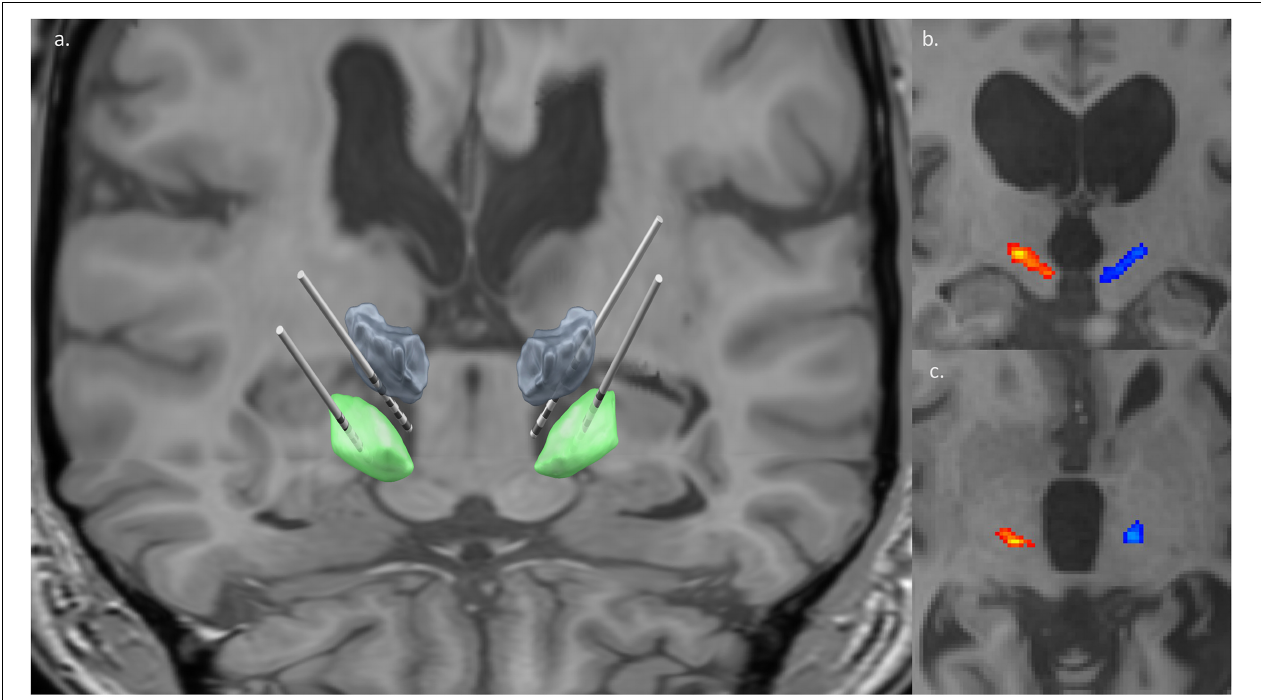
FIGURE 2 | Lead and white matter tract reconstruction. (a) Four DBS [bilateral Vim/DRTT (gray), bilateral GPi (green)] leads reconstructed with patient’s preoperative T1 non-contrast MRI as backdrop and DISTAL atlas segmentations of deep brain nuclei. Two distal contacts of Vim leads can be seen intentionally deep to the nucleus, targeting white matter fiber tracts. Lead visualization generated in Lead-DBS (Horn et al., 2019). (b,c) The right (red) and left (blue) DRTT (dentato-rubro-thalamic tract) are overlaid onto the patient’s T1 non-contrast MRI. The coronal slice (b) showcases the tracking course of the DRTT, while the axial slice (c) captures the DRTT along the AC/PC plane. Tractography images generated in